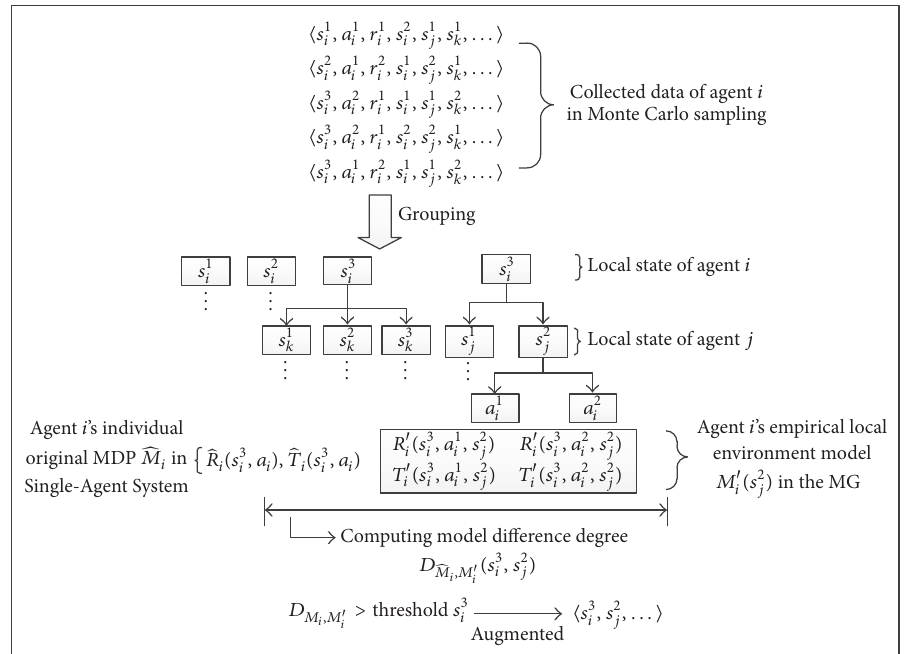
Figure 1: Identify coordinated states with the proposed